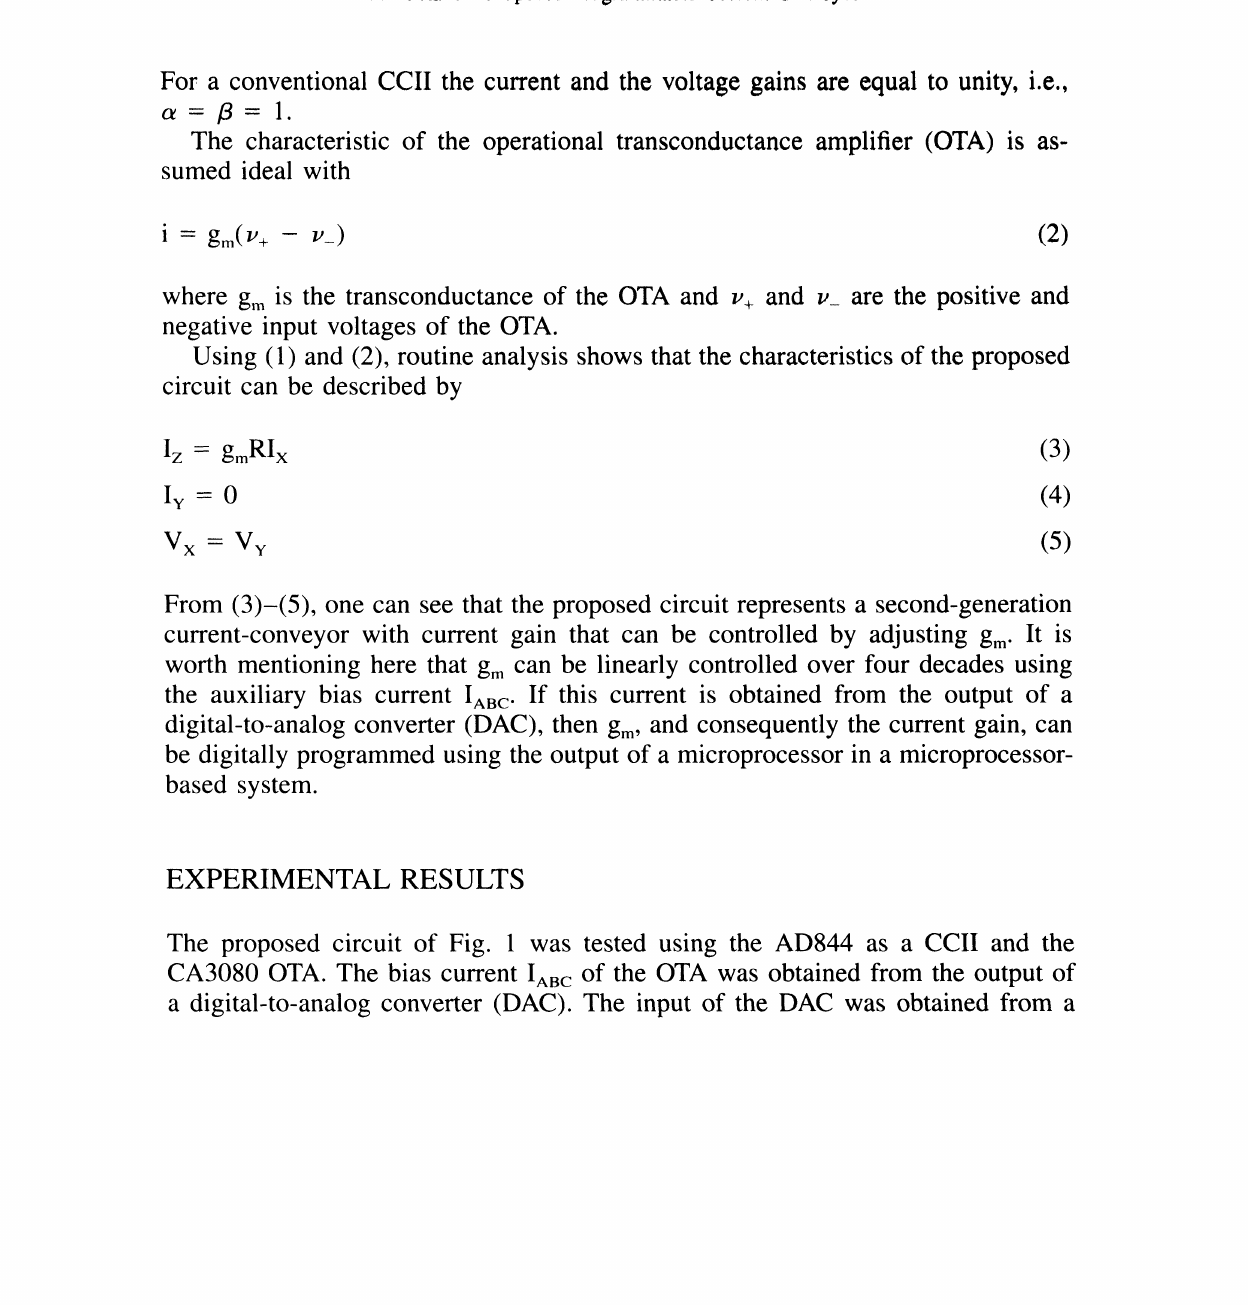
FIGURE Proposed Programmable Current